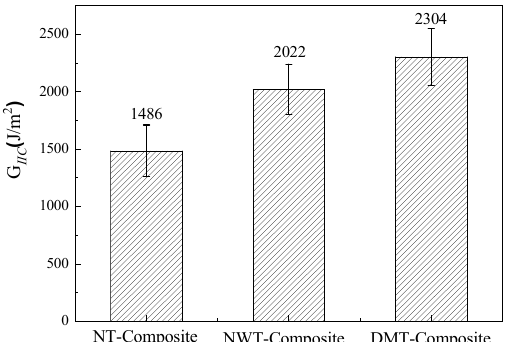
Figure 9. Mode II interlaminar fracture toughness of the three composite laminates.